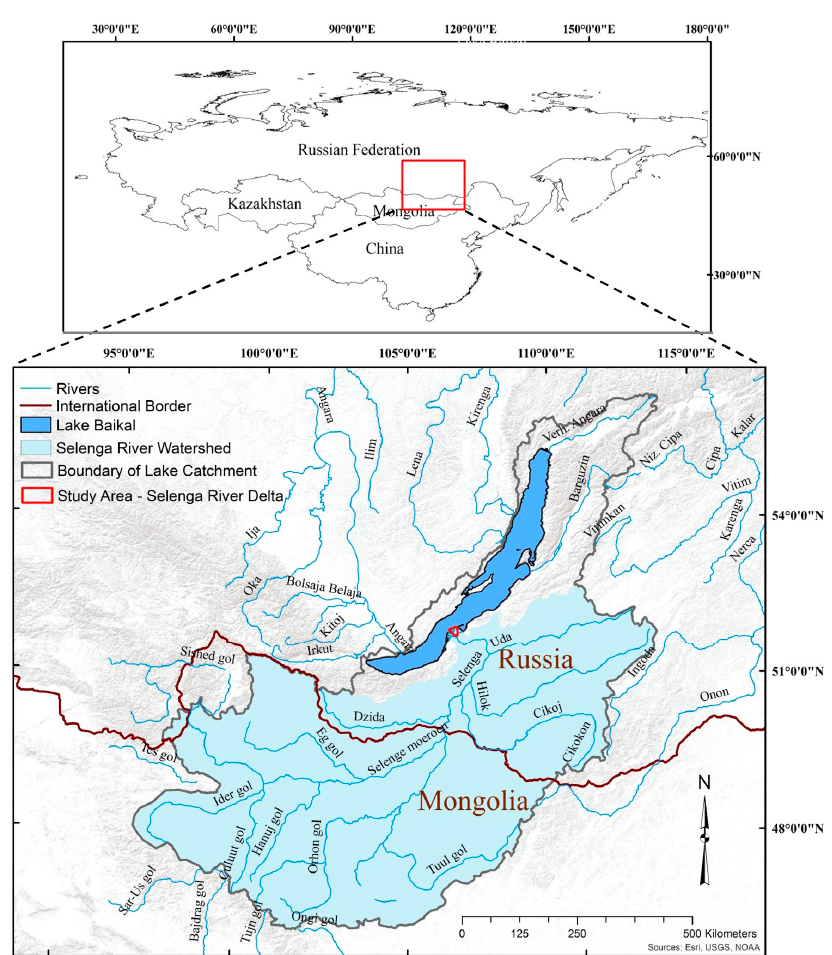
Figure 1. The location of the study area of the Selenga River Delta, a large, freshwater deltaic wetland extending into Russia’s Lake Baikal.